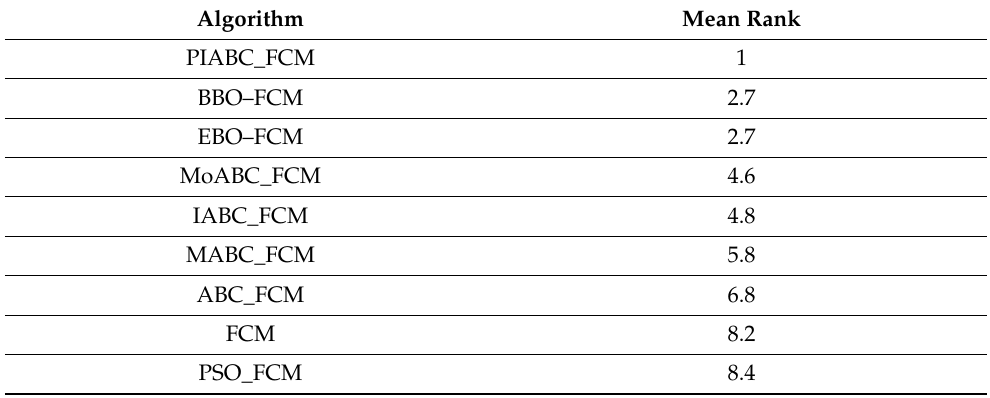
Table 8. Friedman Test based on SC validity index—result for natural images.